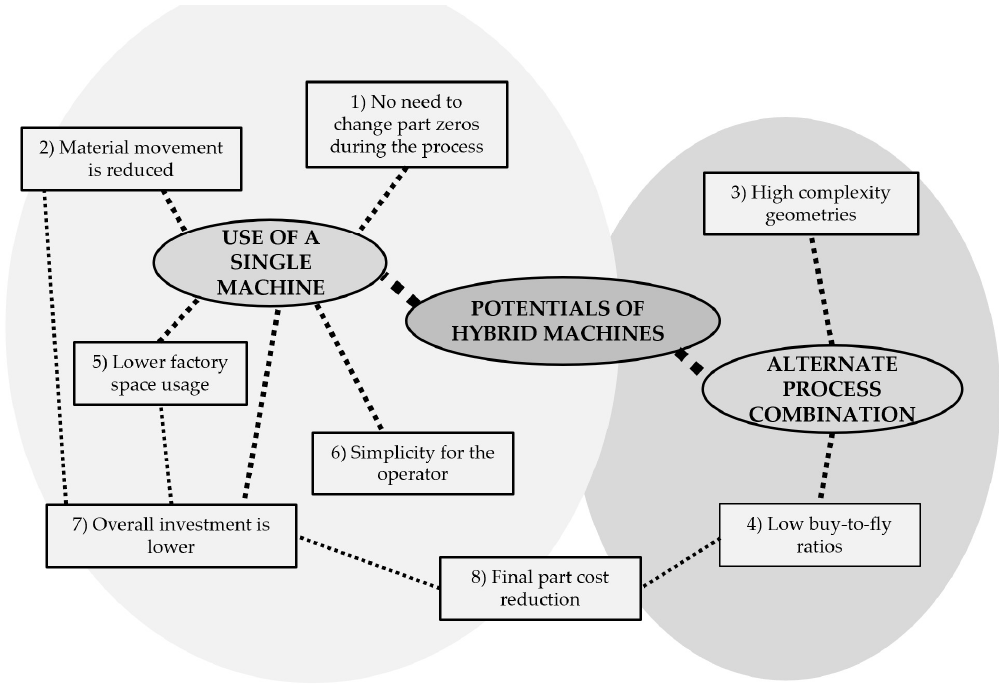
Figure 6. Potentials of the hybrid machines.